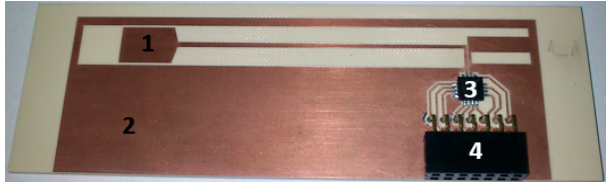
( b ) Figure 19. Connecting antenna to chip: ( a ) Passive construction; ( b ) Semi-passive construction with function of providing voltage output from internal energy harvester. GND—chip ground, AGND—antenna ground. The UHF antenna structure dedicated to cooperating with AMS SL900A and designated to use in proximity of metal surfaces, for implementing in practical application, is presented in Figure 20. This component can be designed properly only when the accurate values of dielectric